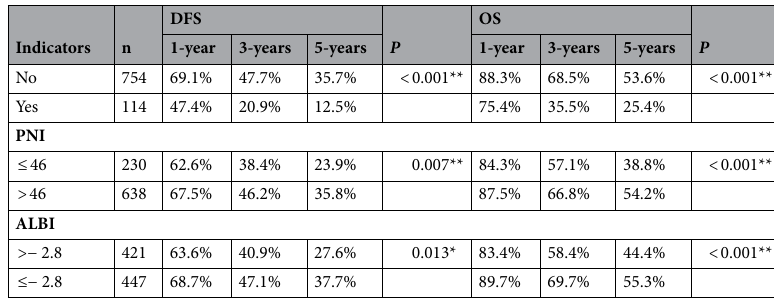
Table 3. Prognostic factors for 1-, 3-, 5-year(s) DFS and OS by univariate analysis.